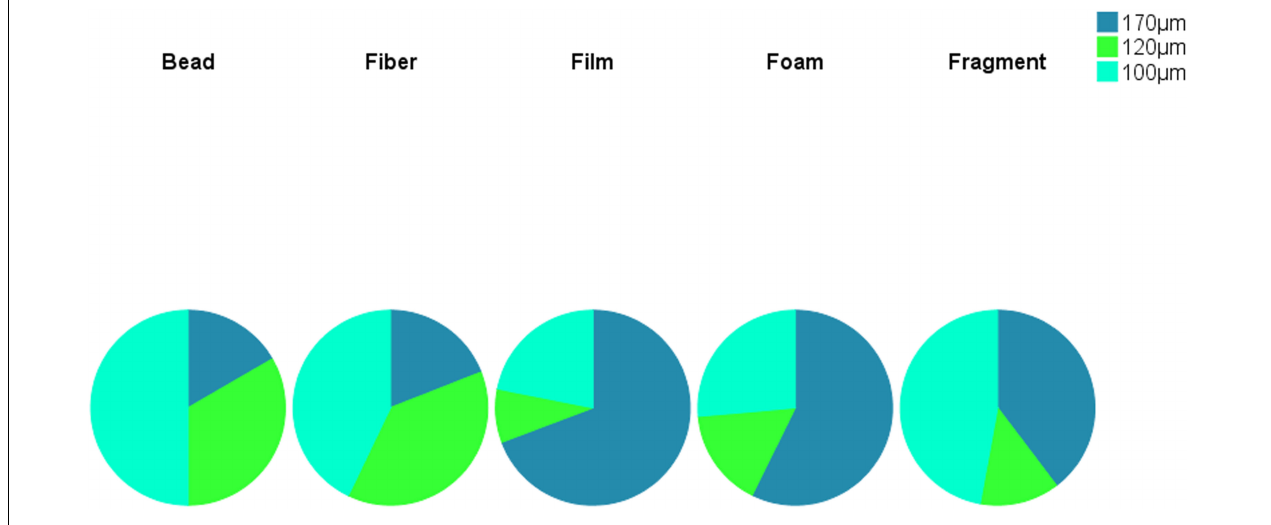
FIGURE 4 | Pie charts demonstrate microplastic particle of (170, 120, 100 µ m) sizes counted and enumerated from the cabs and fishes in this